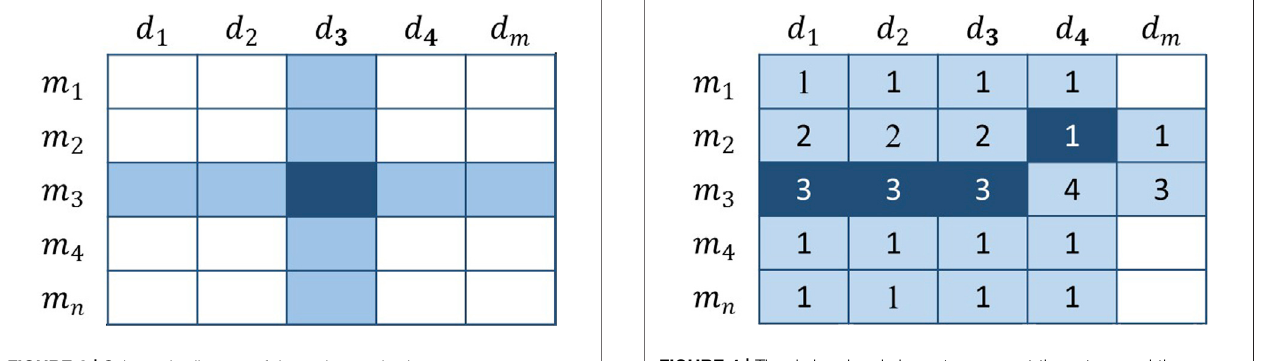
remaining elements are the candidates. The number in the fi gure represents the number of times the current member has been voted and does not represent the fi nal